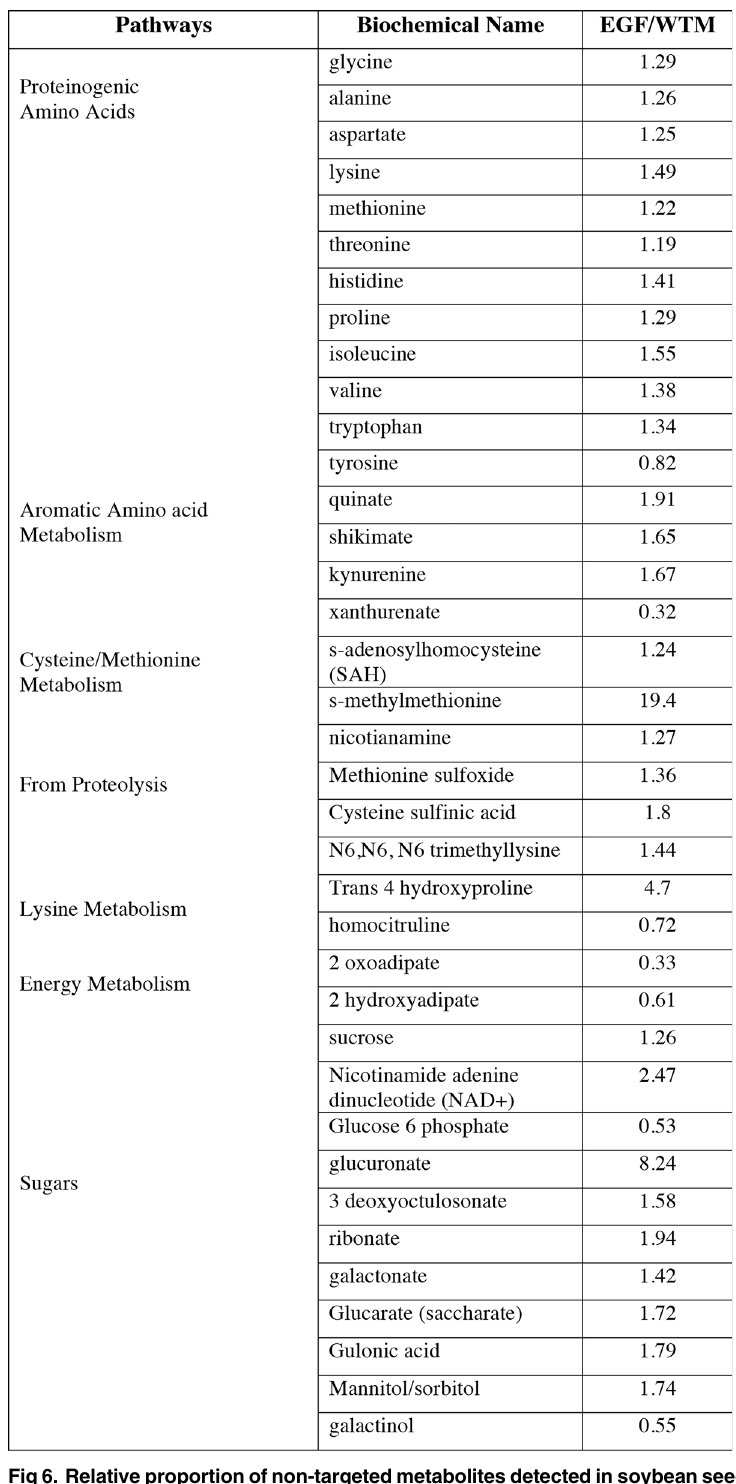
Fig 6. Relative proportion of non-targeted metabolites detected in soybean seeds shown as amount in EGF transgenic compared to nontransgenic (Wt). Complete list of non targeted metabolites quantitated in samples in S1